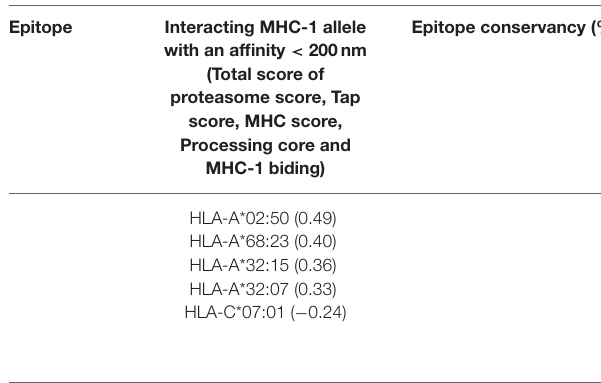
TABLE 2 | MHC–II molecules from the selected peptide